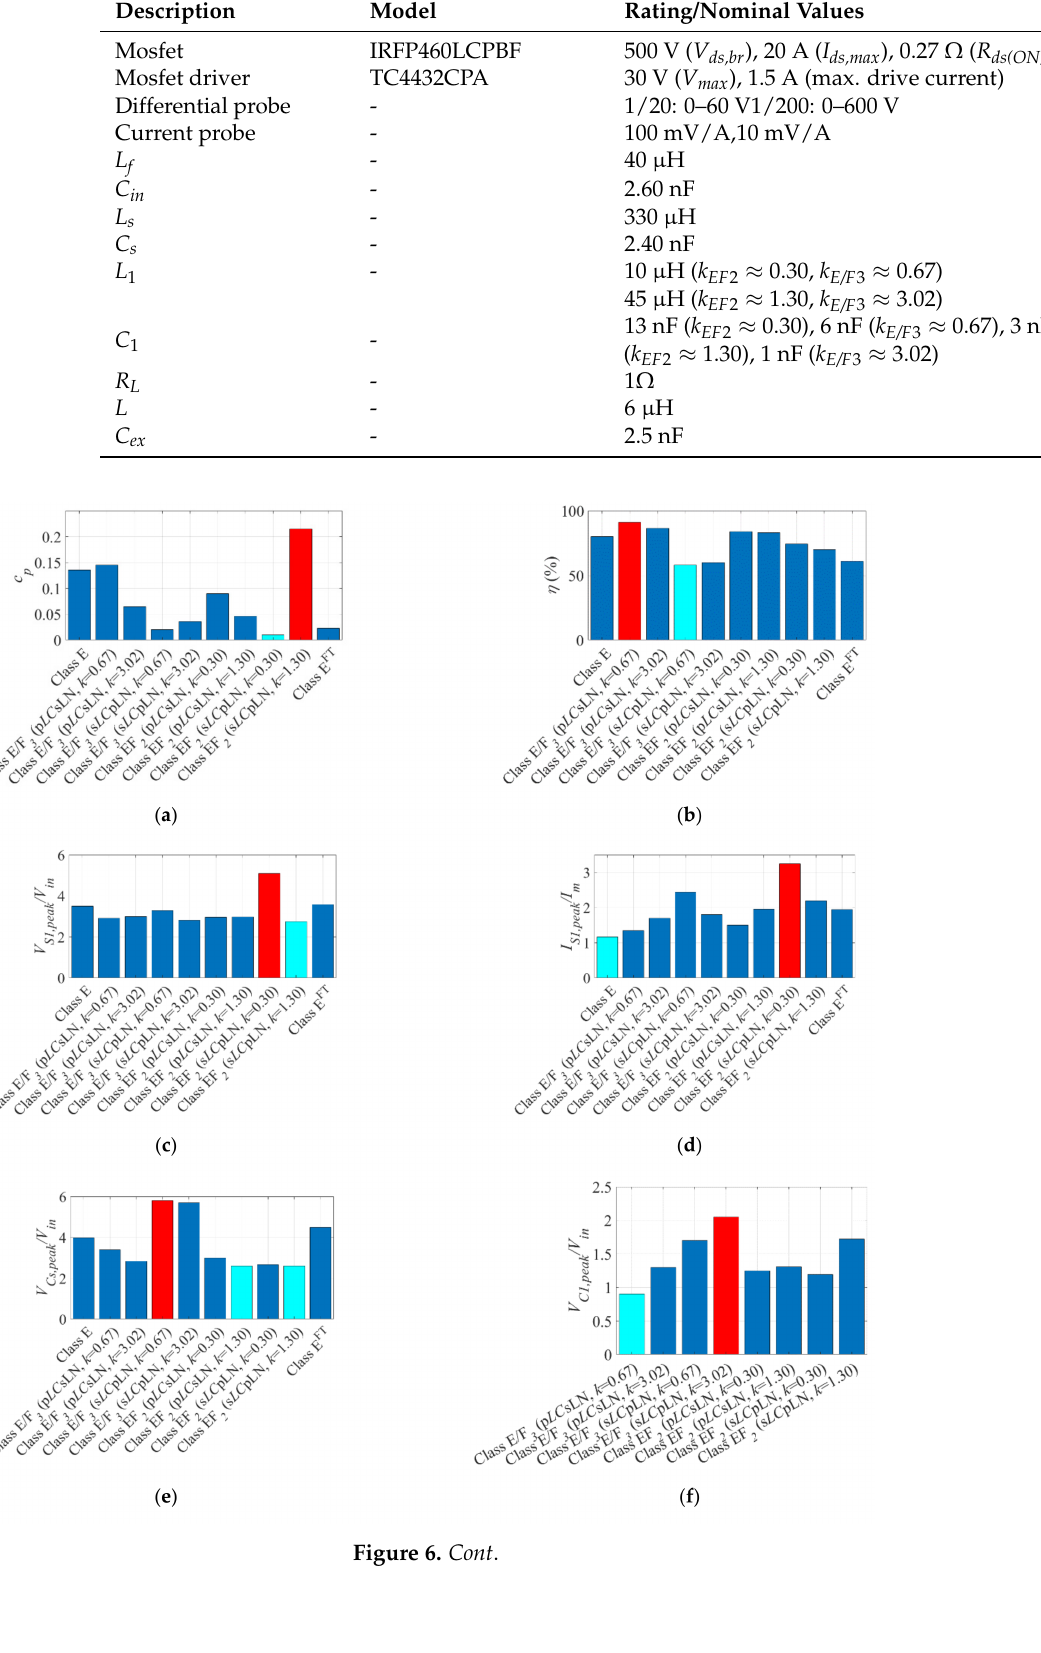
Table 4. List of components and measurement devices used in the prototype inverter testing.